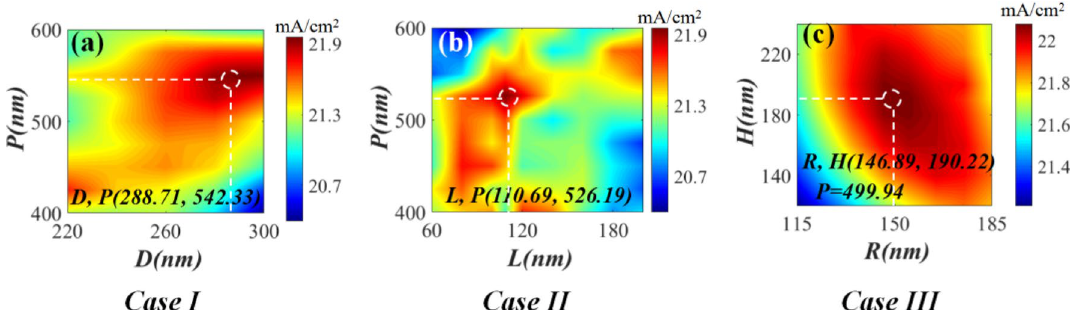
Figure 4. FEM-calculated 2D Jsc maps for the cases I ( a ), II ( b ), and III ( c ) shown in Fig.